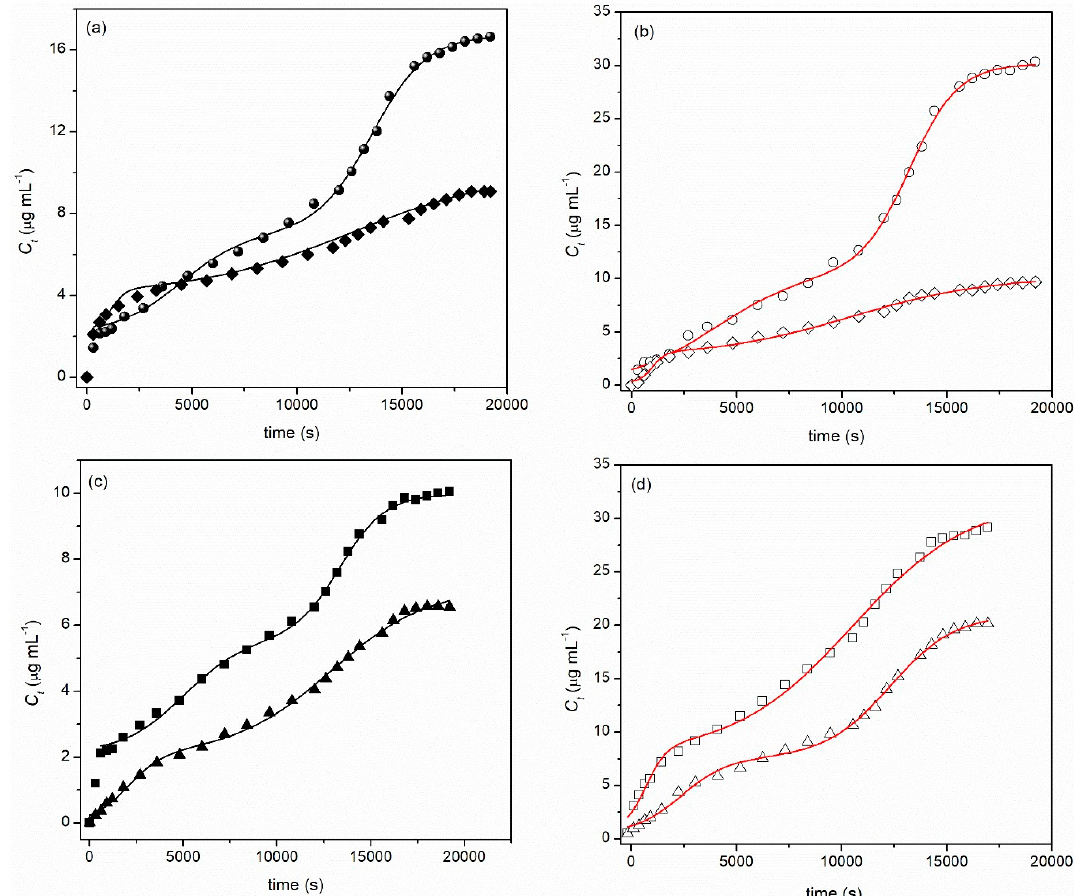
Figure 4. Release profiles of Green Propolis from: ( a,b ) CS-P gels to water (diamonds) and simulated saliva (circles), at 25 °C ( a ) and 37 °C ( b ); ( c,d ) CS-DNA gels to water (triangles) and simulated saliva (squares), at 25 °C ( c ) and 37 ° C ( d )). Solid lines were obtained by fitting eq. (1) to the experimental data.